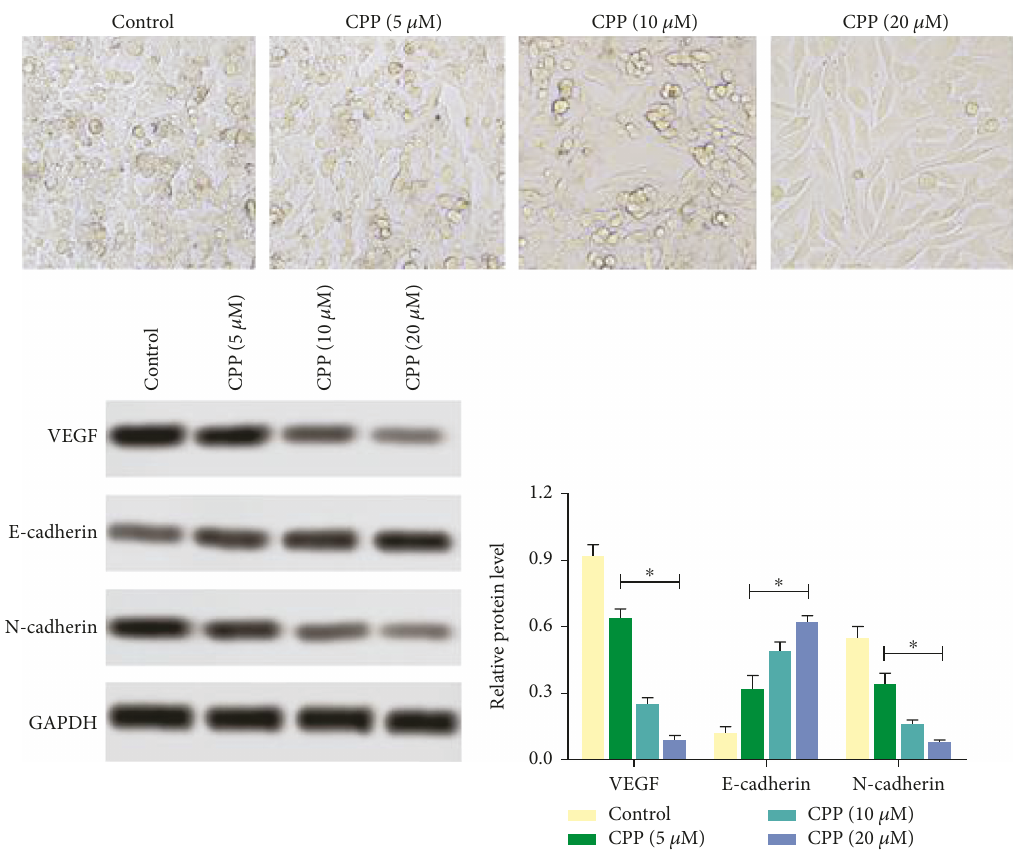
Figure 5: Expression of EMT-related protein in HepG2 cells. ∗ P < 0 05 versus Control